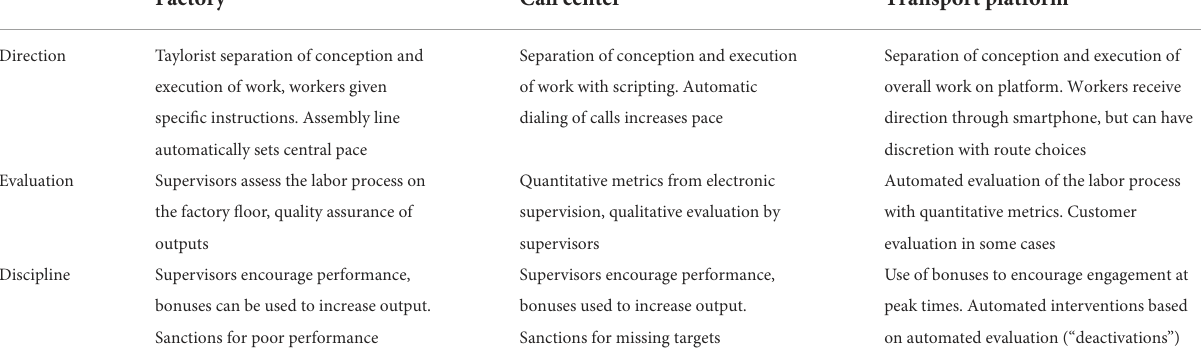
TABLE 1 Systems of